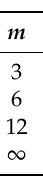
Table 1. The voltage ripple factor values of different pulse number m